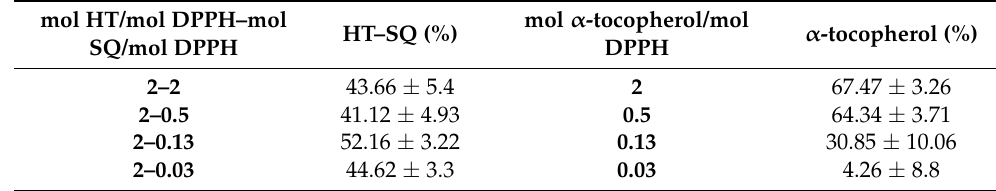
Table 1. Percentage of Free Radical Scavenging Activity of HT–SQ and α -tocopherol measured by the reduction in the DPPH Radical (% RSA at t =